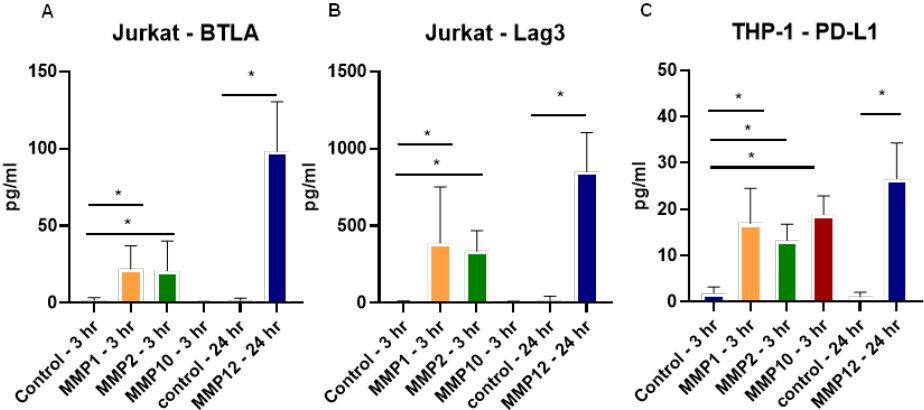
Figure 5. MMPs cleave checkpoint molecules from T cells and monocytes where cells are treated with recombinant MMPs activated in AMPA buffer and ( A ) BTLA and ( B ) Lag3 are cleaved from Jurkat T cell line, and ( C ) PD-L1 is cleaved from THP-1 cells in supernatants. N = 6, * p < 0.05.